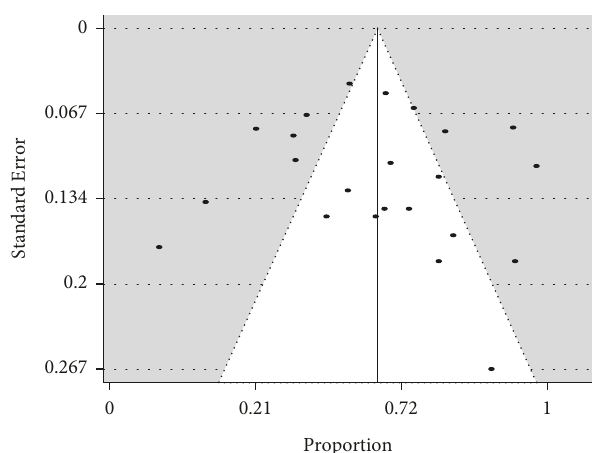
Figure 4: Funnel plot of the included